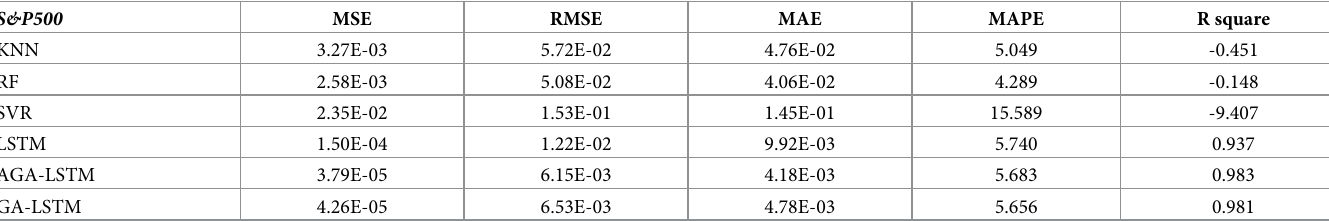
Table 8. The evaluation indexes of AGA-LSTM model and other DL models in S&P500 date set. S&P500